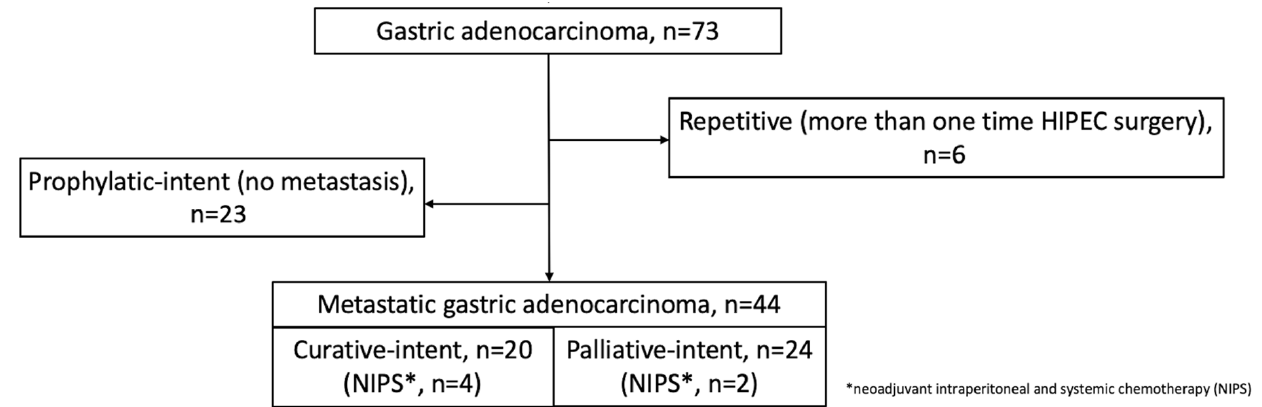
Figure 1. The flow diagram of the current study. Consecutive gastric cancer-associated peritoneal carcinomatosis (GCPC) patients in the institutional cytoreductive surgery with hyperthermic intraperitoneal chemotherapy (CRS-HIPEC) database during 2015 to 2021 were reviewed ( n = 73). Exclusion was made for those who were non-metastatic GC patients receiving prophylactic HIPEC procedure ( n = 23) and those who received repetitive CRS-HIPEC operations ( n = 6). A total of 44 patients of CRS-HIPEC procedures, with 20 cases in the curative-intent group and the other 24 cases in the palliative-intent group, were enrolled for further overall survival (OS) analysis.